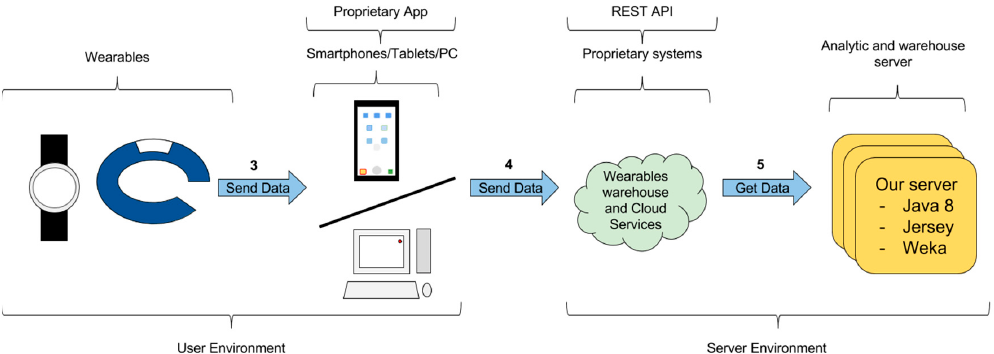
Figure 6. System representation for the warehouse data transfer—direct access.